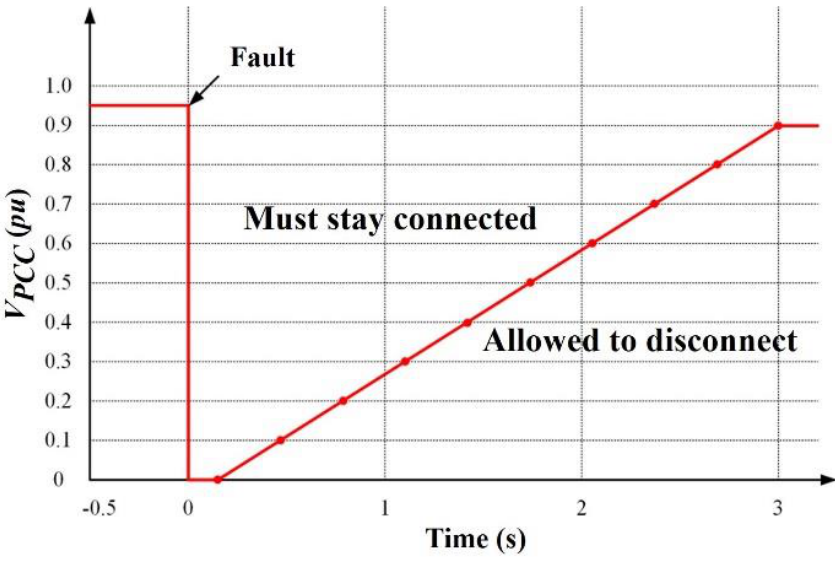
Figure 11. Low voltage ride through (LVRT) curve for Taiwan Power Company.